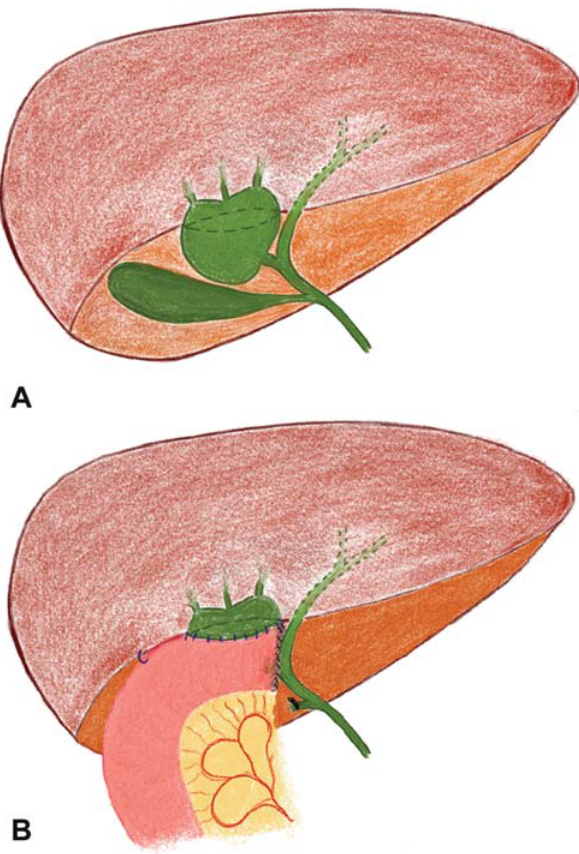
Fig. 1 Case 1: ( A ) schematic drawing of the choledochal malforma- tion of the right-hepatic duct; ( B ) postoperative right-hepatic duct